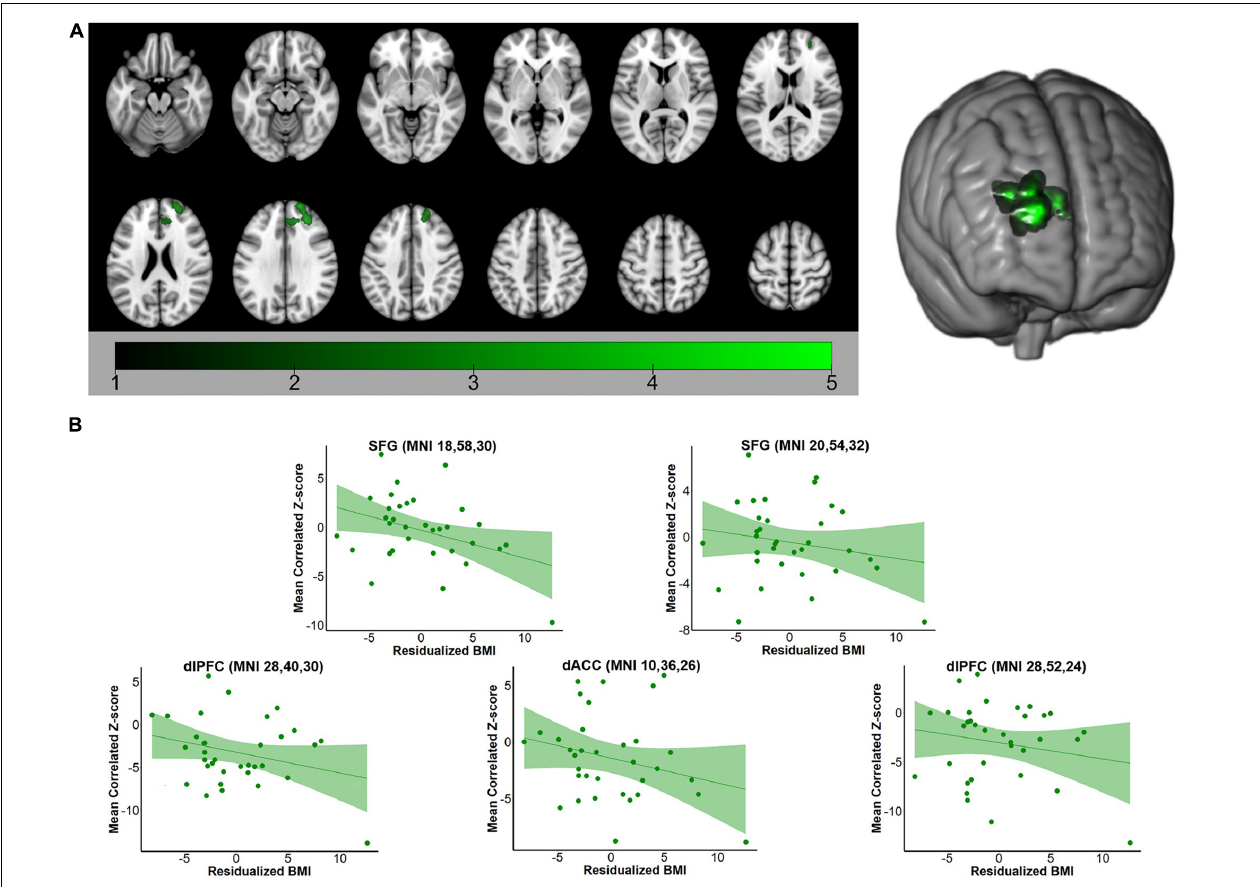
FIGURE 2 | (A) Whole-brain map of regions exhibiting negative associations between BMI and intrinsic connectivity with the amygdala. Map was cluster thresholded at z > 2.3 and p < 0.05. (B) Scatterplots of the relationship between BMI and amygdala-to-ROI signal covariation at rest. Note that mean framewise displacement, age, and education were regressed out of BMI values prior to plotting. BMI, body mass index; SFG, superior frontal gyrus; dlPFC, dorsolateral prefrontal cortex; dACC, dorsal anterior cingulate cortex.